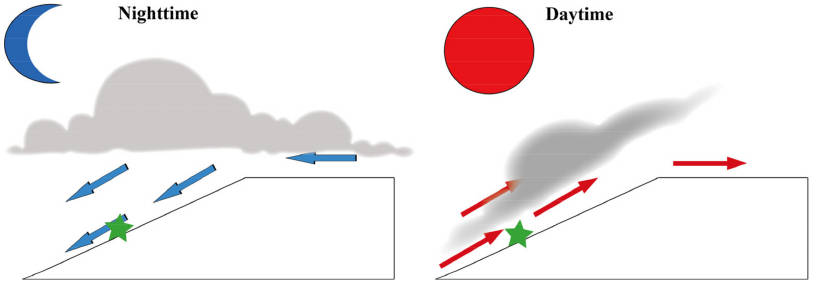
Figure 11. Diurnal variations in ( a ) temperature at 2 m (°C), and ( b ) wind direction at 10 m (°) during the observation period at Xinyuan Meteorological Station. On each box, the central crossbar indicates the median, and the bottom and top edges of the box indicate the 25th and 75th percentiles, respectively. The black whiskers extend to the maximum and minimum of the data points, respectively. The green dashed, blue dashed and purple dashed lines are the positions of east wind, south wind and west wind, respectively.